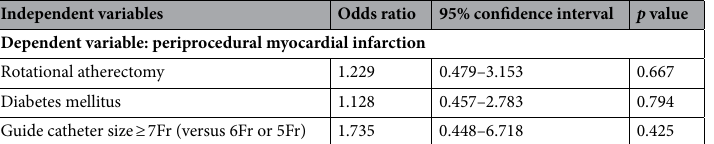
sity score matching generated 380 lesions (190 lesions in each group), which was almost similar to the estimated sample size. Therefore, the possibility of a Type II error (ß error) might be minimum. Moreover, the standardized difference of PMI between the 2 matched groups was 0.086. Since a standardized difference < 0.1 has been taken to indicate a negligible difference in the prevalence of a covariate between the 2 groups irrespective of the study sample size 36,48 , it is appropriate to mention that use of RA would not increase the risk of PMI in complex lesions.